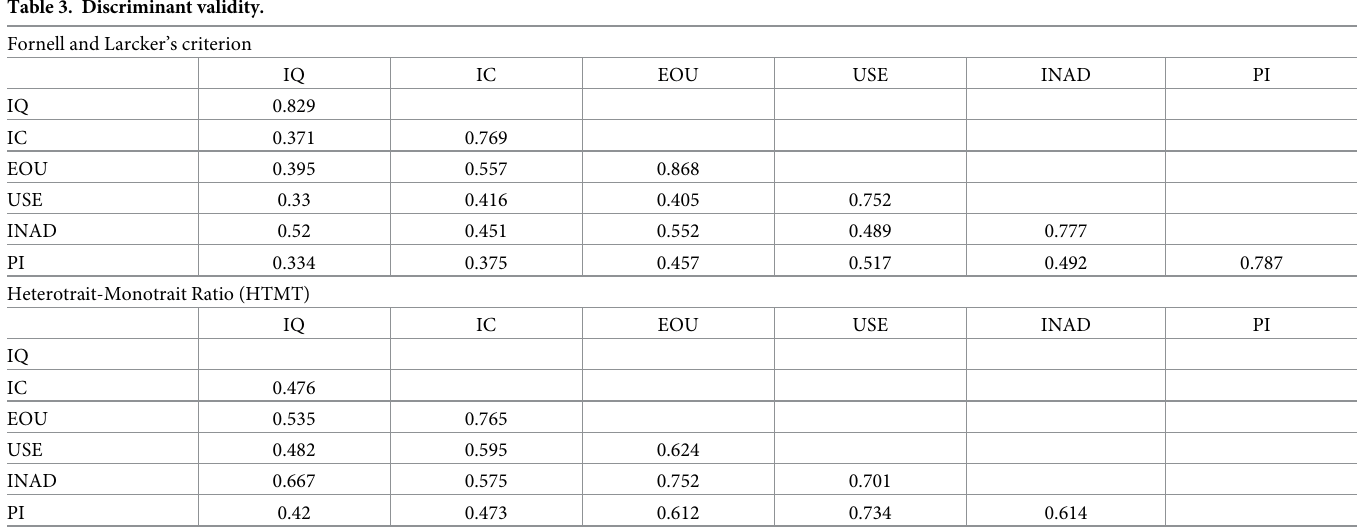
Table 3. Discriminant validity.